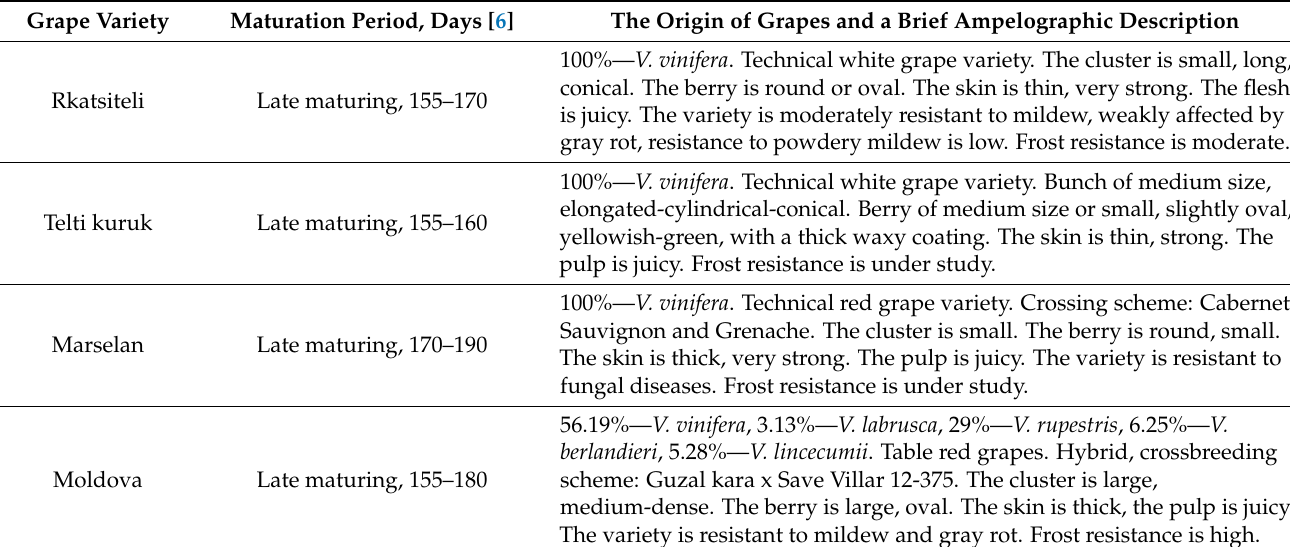
Table 1. Description of grape variety, maturation, and species of Vitis